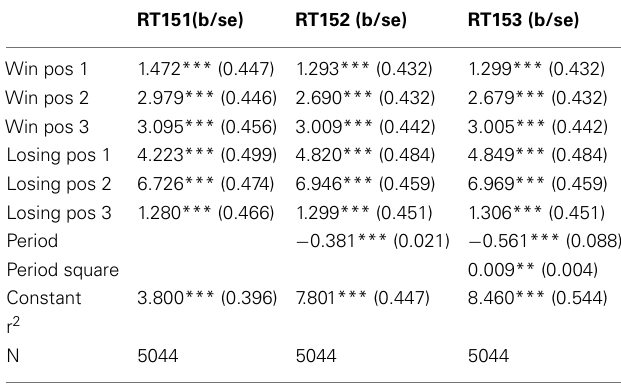
Table 2 | Response time in G(15, 3): panel data analysis.